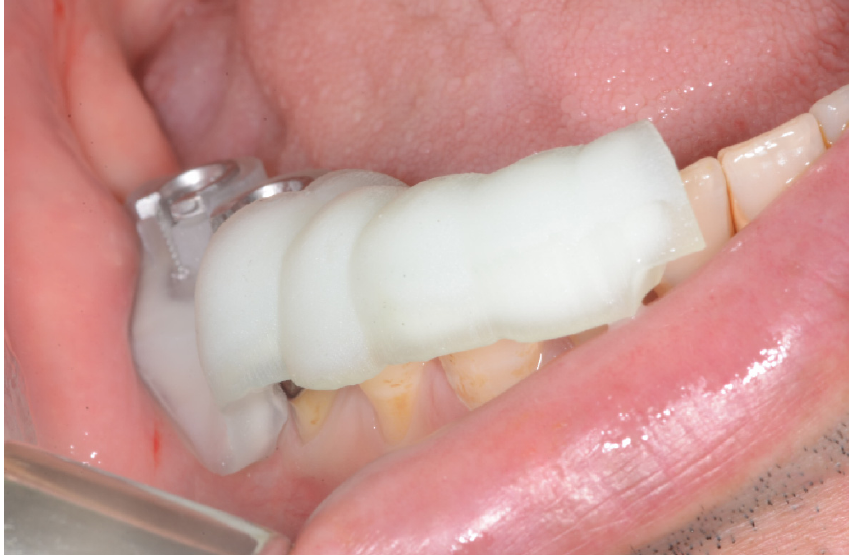
Figure 2. Surgical guide for pilot-guide implant surgery; tooth-supported.